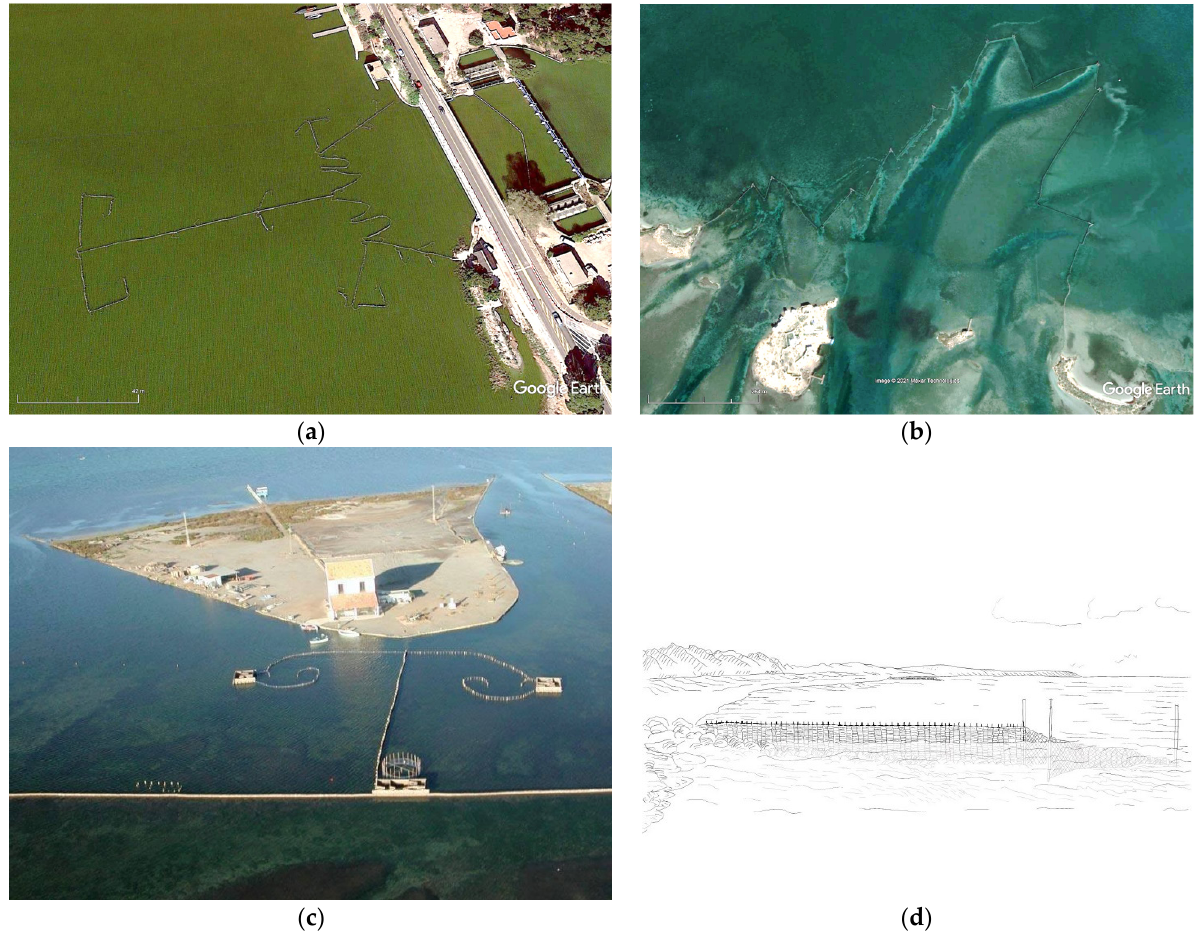
Figure 7. Current fishing set-up systems used in Mesopotamia in various coastal lagoons: ( a ) Redolín in Albufera de Valencia (Spain) March 2020. ( b ) Charfia in El Bibane (Tunisia). ( c ) Encañizada in Mar Menor (Spain) March 2017 (Archive of Murcia County Government). ( d ) Reconstruction of a fish hedge from Oleslyst, Denmark, about 4500 years old, sketch traced by J.S. [37].